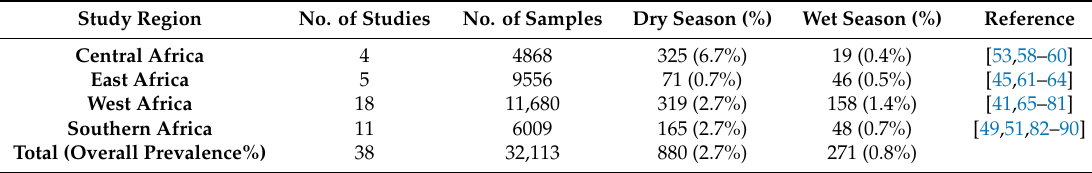
Table 3. Prevalence of AIV according to regions and seasons a